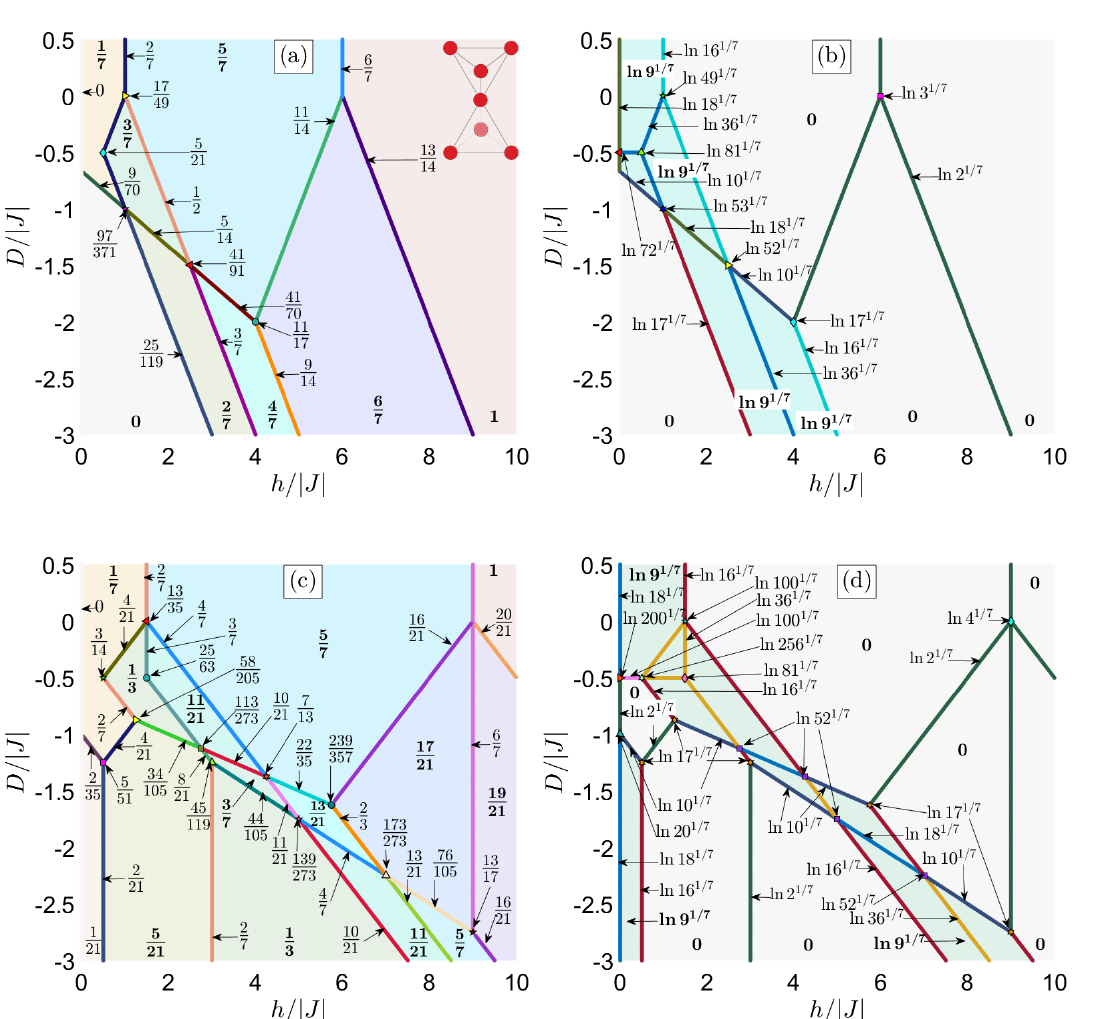
Figure 3. Ground state values of ( a , c ) the normalized magnetization m / m sat and ( b , d ) the entropy density S / Nk B of the 2CS cluster with ( a , b ) s = 1 and ( c , d ) s = 3/2, in the ( h / | J | , D / | J | ) parameter plane. Boldface (plane) values correspond to the interior (boundaries) of the respective phases. The inset in ( a ) shows the 2CS